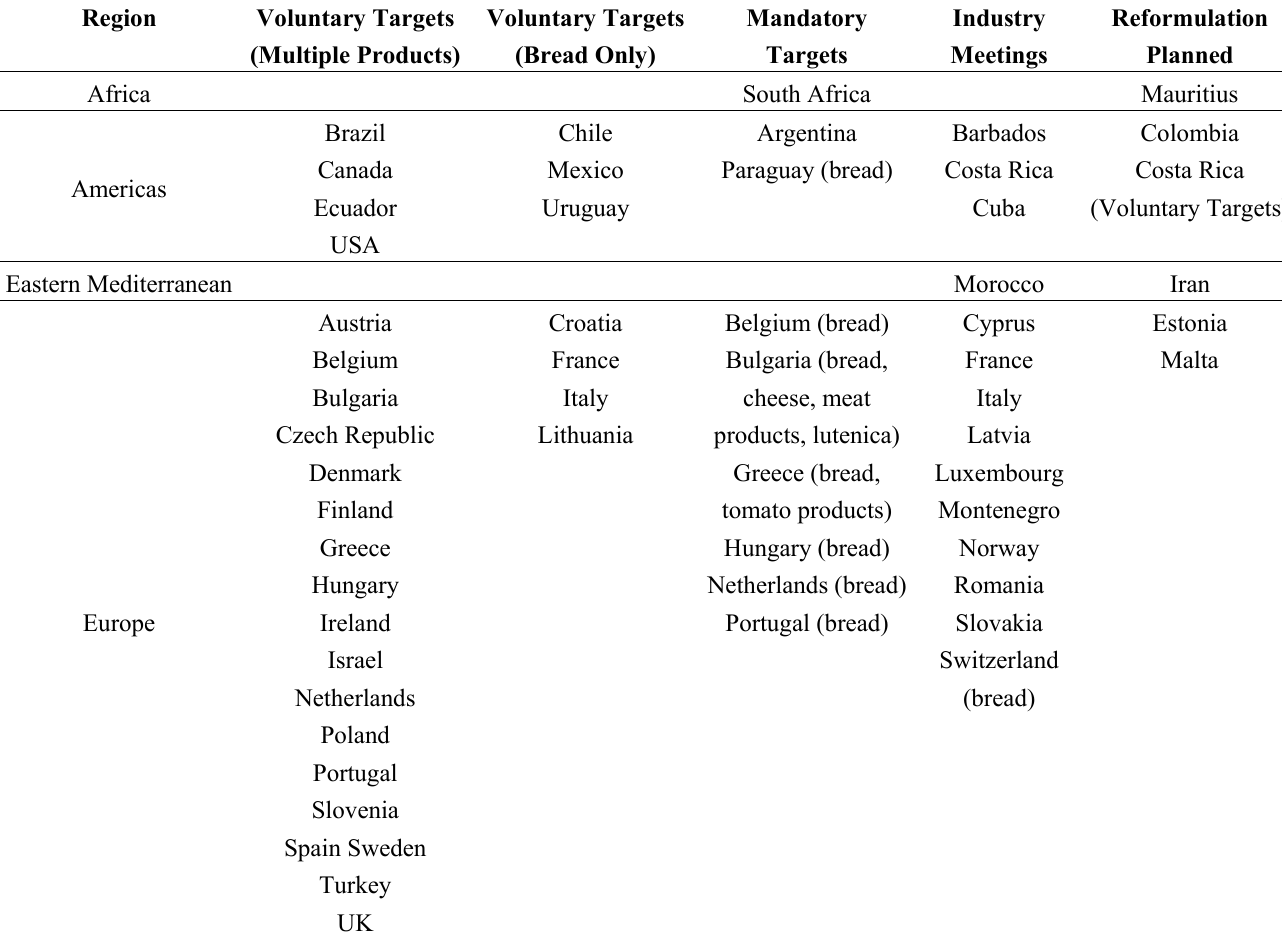
Table 1. National approaches to working with the food industry to reduce salt in foods.